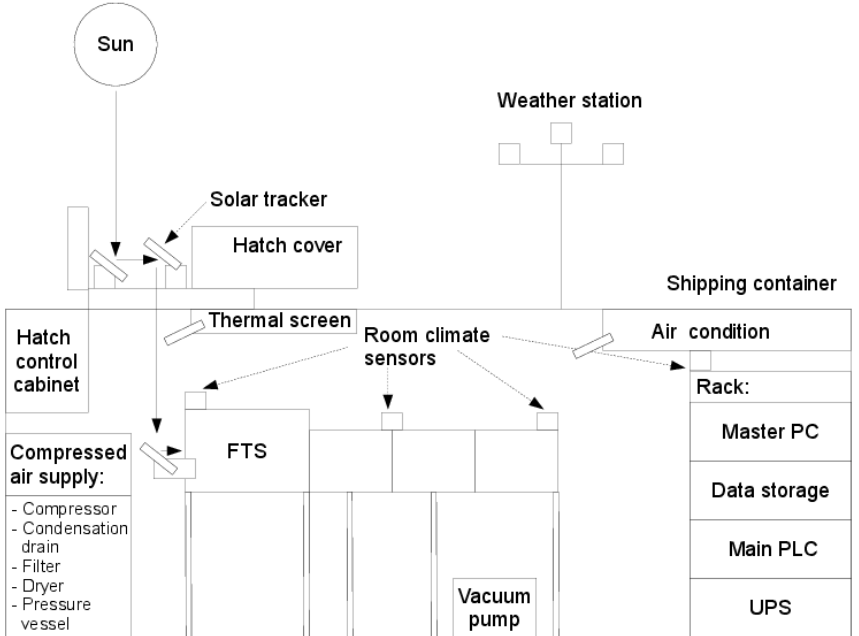
Fig. 2. Schematic of the FTS observatory. The automation system with its hardware for the general data acquisition is depicted. Further details of the components can be found in the